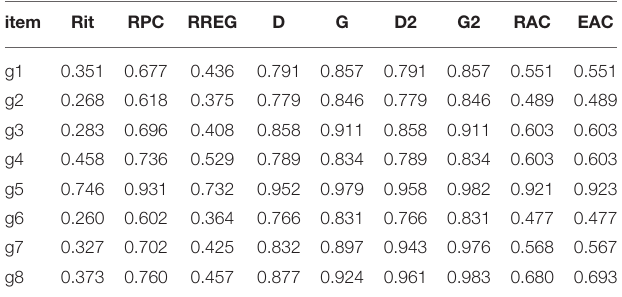
TABLE 3c | Estimators of correlation between the item and raw score.